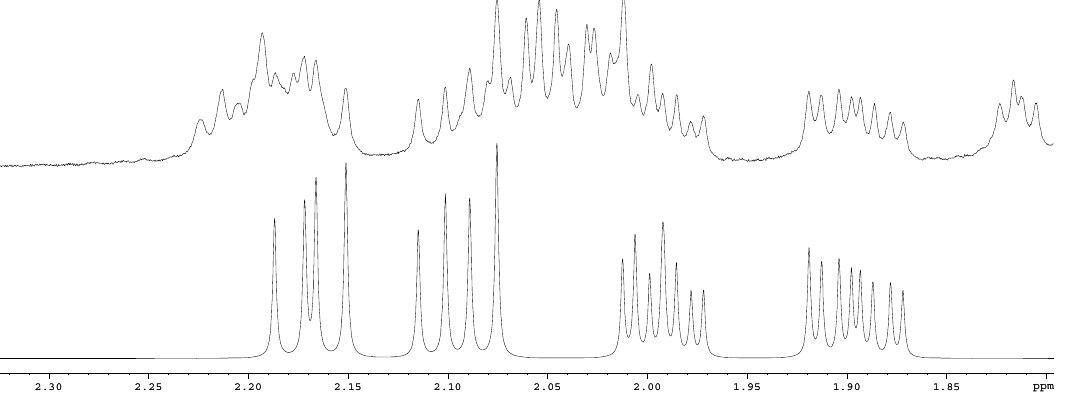
Figure A1. (top) Real and (bottom) simulated (fragment of pyrrolidine ring) 1 H-NMR spectra. Weak cross-peaks in the 1 H, 1 H–NOESY spectrum showed interaction of the methyl group at 1.09 ppm with protons at 2.17 ppm (methylene group of pyrrolidine ring) and at 2.05 ppm (ethyl group). Some cross-peaks for the other side of molecule were also detected: between signals at 0.93 and 2.58 ppm, 1.72 and 2.08 ppm, 1.79 and 1.90 ppm, 2.03 and 2.18 ppm. So, we can conclude that tert -butyl and ethyl groups were oriented in the same plane with hydrogen atoms at 2.08 and 2.17 ppm of the pyrrolidine cycle.